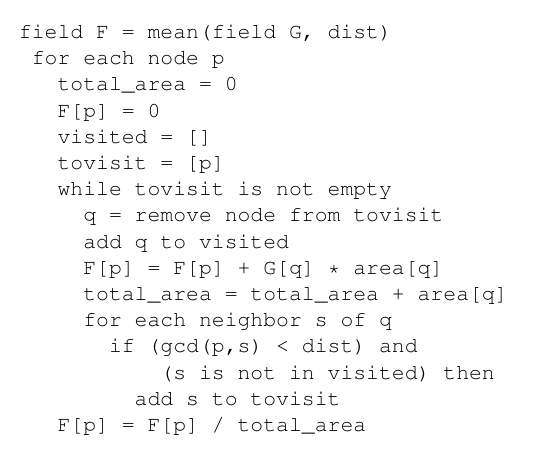
Algorithm 1 Compute the spatial mean value of a field G over a region of radius dist using graph search on an un-